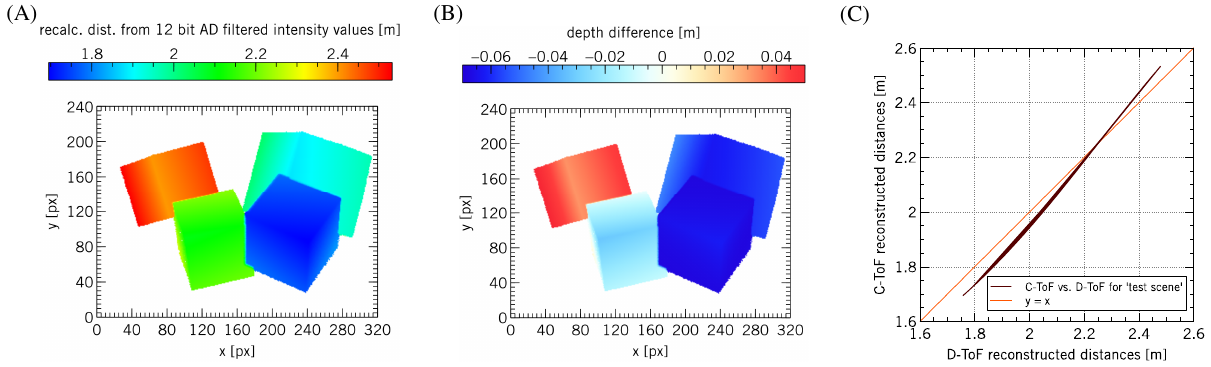
Figure 5. Test scene from Figure 4, but the depth is reconstructed with the single frequency PMD based C-ToF sensor model. (A) Calculated depth from the optical path length using the global magnification factor correspondence. (B) Difference between D-ToF and C-ToF depth calculation. (C) C-ToF vs. D-ToF emphasising the arctangent behaviour of the C-ToF reconstruction algorithm.